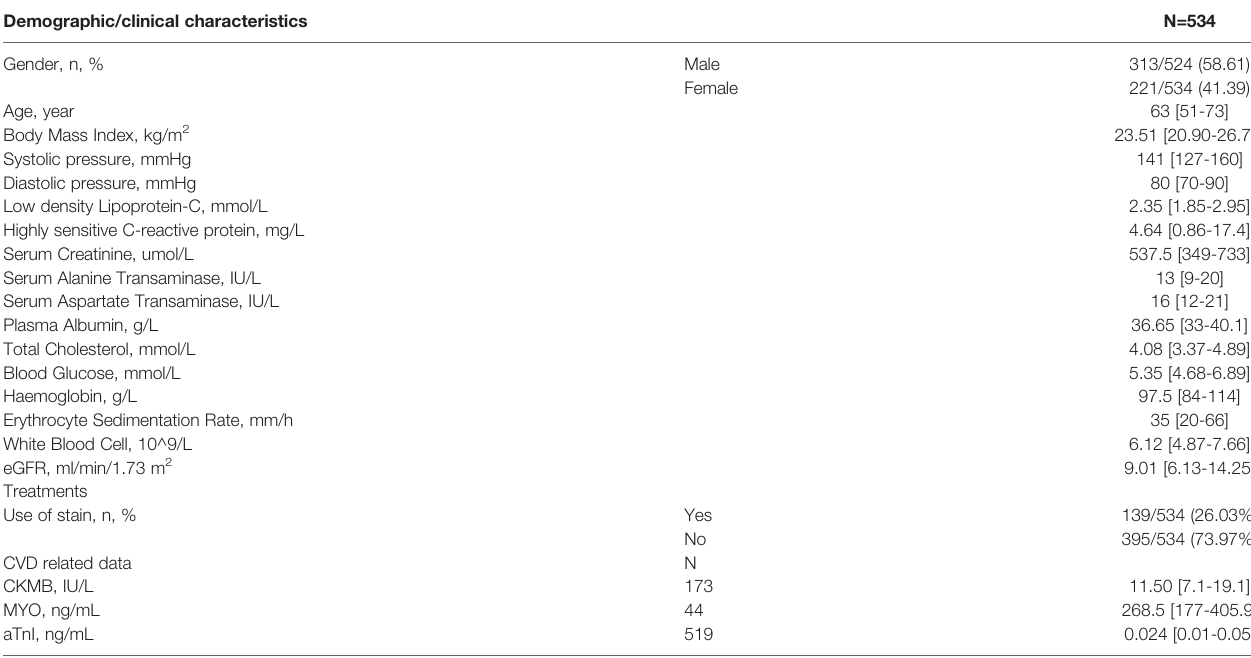
TABLE 2 | Clinical characteristics of patients in predicting model of